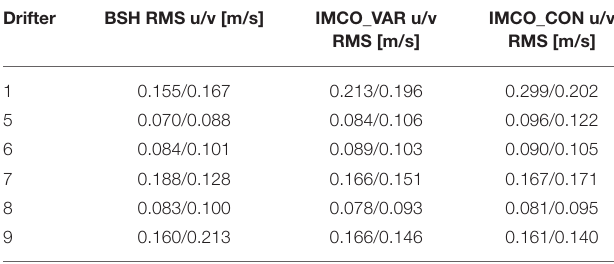
TABLE 3 | RMS differences between drifter derived surface velocities and drift model data from BSH as well as the 4DVAR results. Drifter